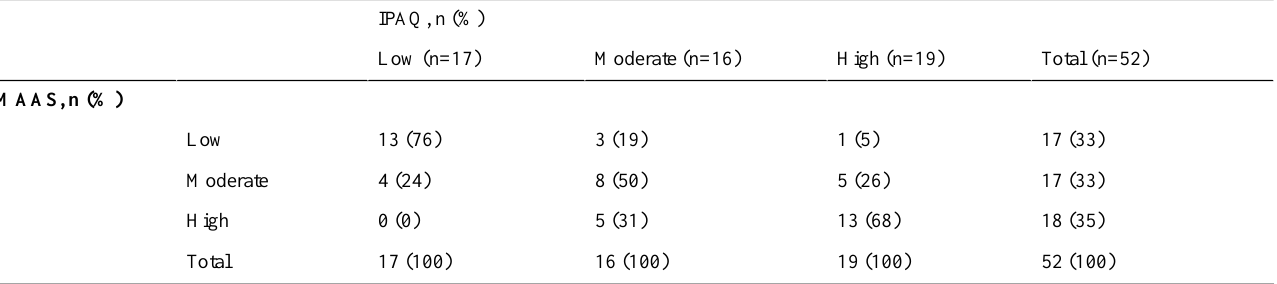
Table 3. Categorical outcomes from MAAS a and IPAQ b follow-up questionnaires. IPAQ, n